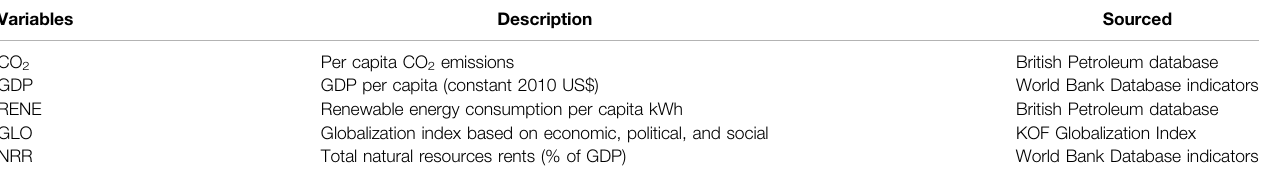
TABLE 1 | Description of the variable.